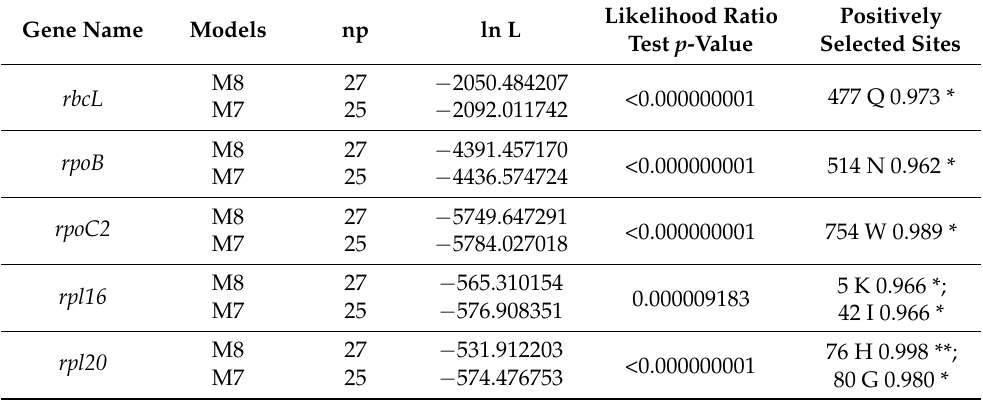
Table 2. Log-likelihood values of the site-specific models, with detected sites having dN/dS values